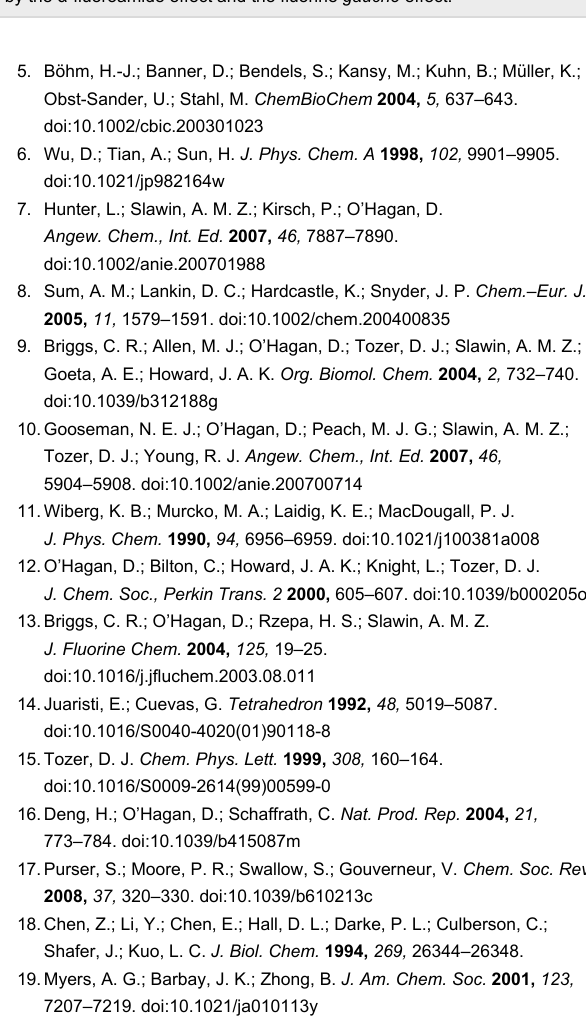
Figure 19: The conformations of pseudopeptides 69 and 70 are influenced by the α -fluoroamide effect and the fluorine gauche effect.